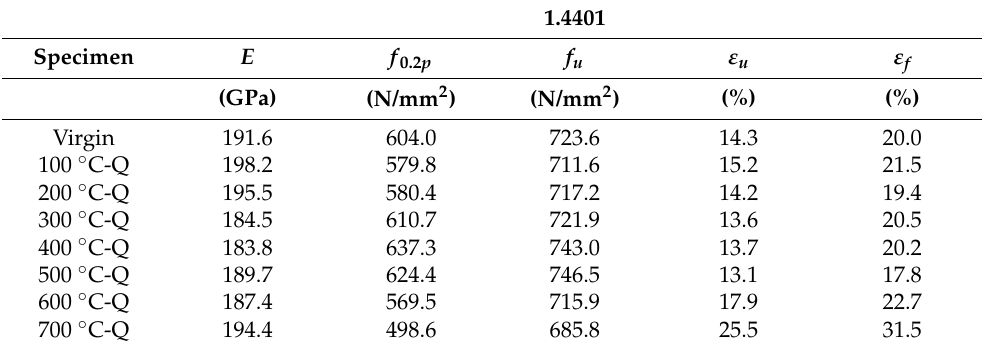
Table 4. Post-fire mechanical properties of grade 1.4401 stainless steel reinforcing